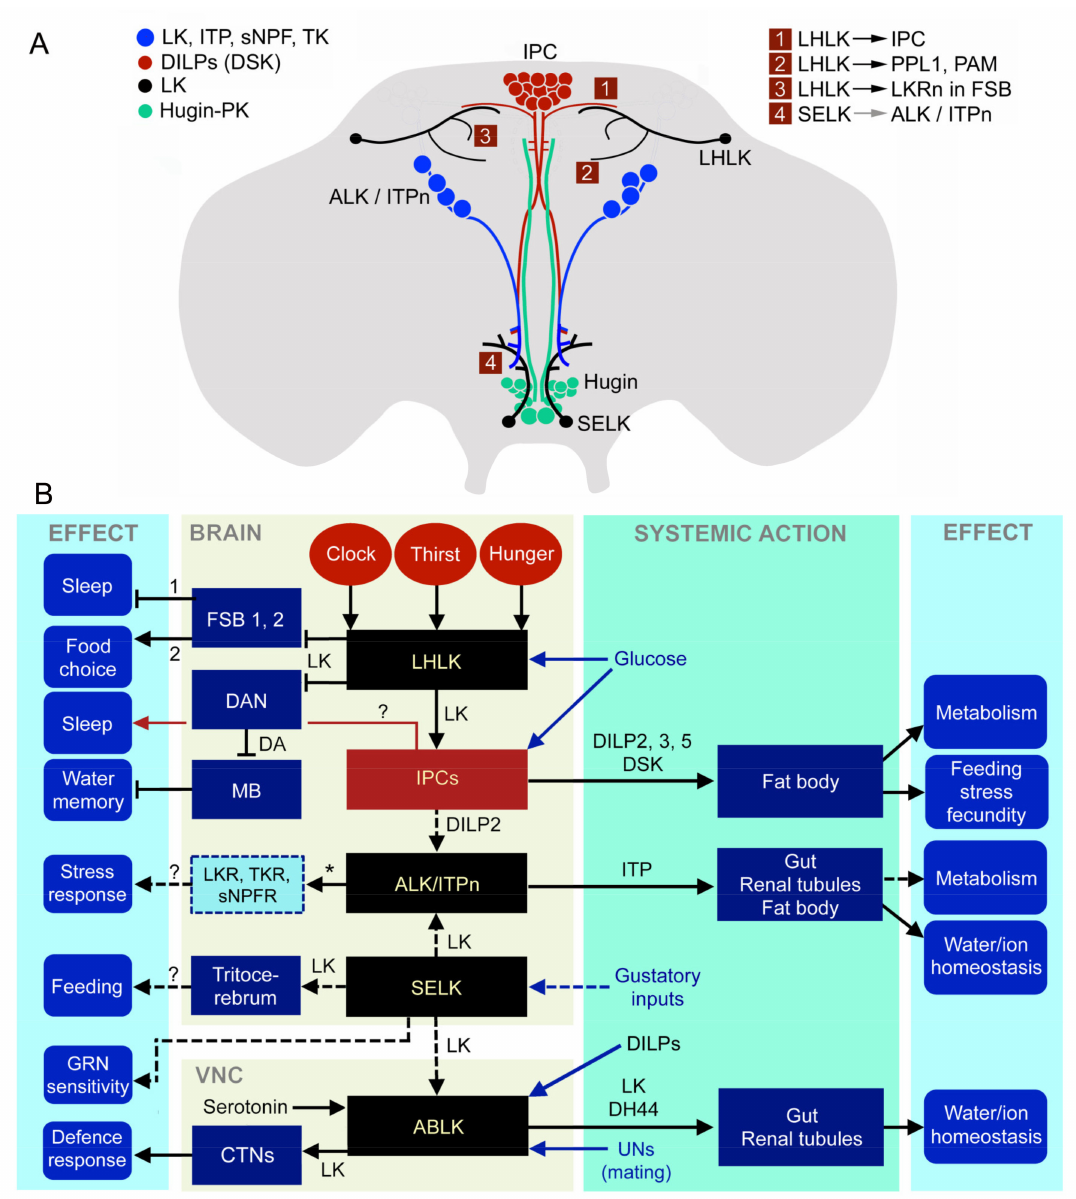
Figure 12. Summary diagrams of leucokinin functions in Drosophila . ( A ) Schematic depiction of LK neurons in relation to neurosecretory cells in the adult Drosophila brain. LHLKs act on insulin-producing cells (IPCs), dopaminergic neurons (PPL1 and PAM subtypes) and at least two types of LK-receptor expressing neurons (LKRn; FSB 1 and 2 in B) innervating the fan-shaped body (FSB). SELKs may act on the ALK/ITPn that express the LKR. The Hugin neurons of the subesophageal zone are also shown since they form a link between gustatory sensory cells and feeding circuits, including IPCs. The numbered boxes (1–4) indicate sites of interaction between neurons. Data derived from [38,48,110,117]. ( B ) Schematic diagram of functional connections between LK neurons and other neurons, circuits and peripheral targets. Arrows indicate various actions, dashed arrows suggest presumed actions and the stop bars indicate inhibitory action. The LK neurons in the brain and ventral nerve cord (VNC) are shown as black boxes and the insulin-producing cells (IPCs) as a dark red box. Target neurons of LHLKs are shown as dark blue boxes with two types of LKR-expressing neurons of the fan-shaped body (FSB 1, 2; these are LKR neurons and FB16 neurons), dopaminergic neurons (DANs; these are PPL1 and PAM neurons) and mushroom body-associated neurons (MB). LKR neurons inhibit sleep [110] and FB16 neurons regulate food choice [117], whereas MB neurons, via dopamine (DA) inputs, mediate water (and sugar) memory [116]. LHLKs are glucose-sensing and receive inputs from neuronal circuits of the circadian clock and systems sensing thirst and hunger (red ellipses). LHLKs signal with LK to IPCs, which regulates sleep–metabolism interactions [38,48]. IPCs are nutrient-sensing and are known